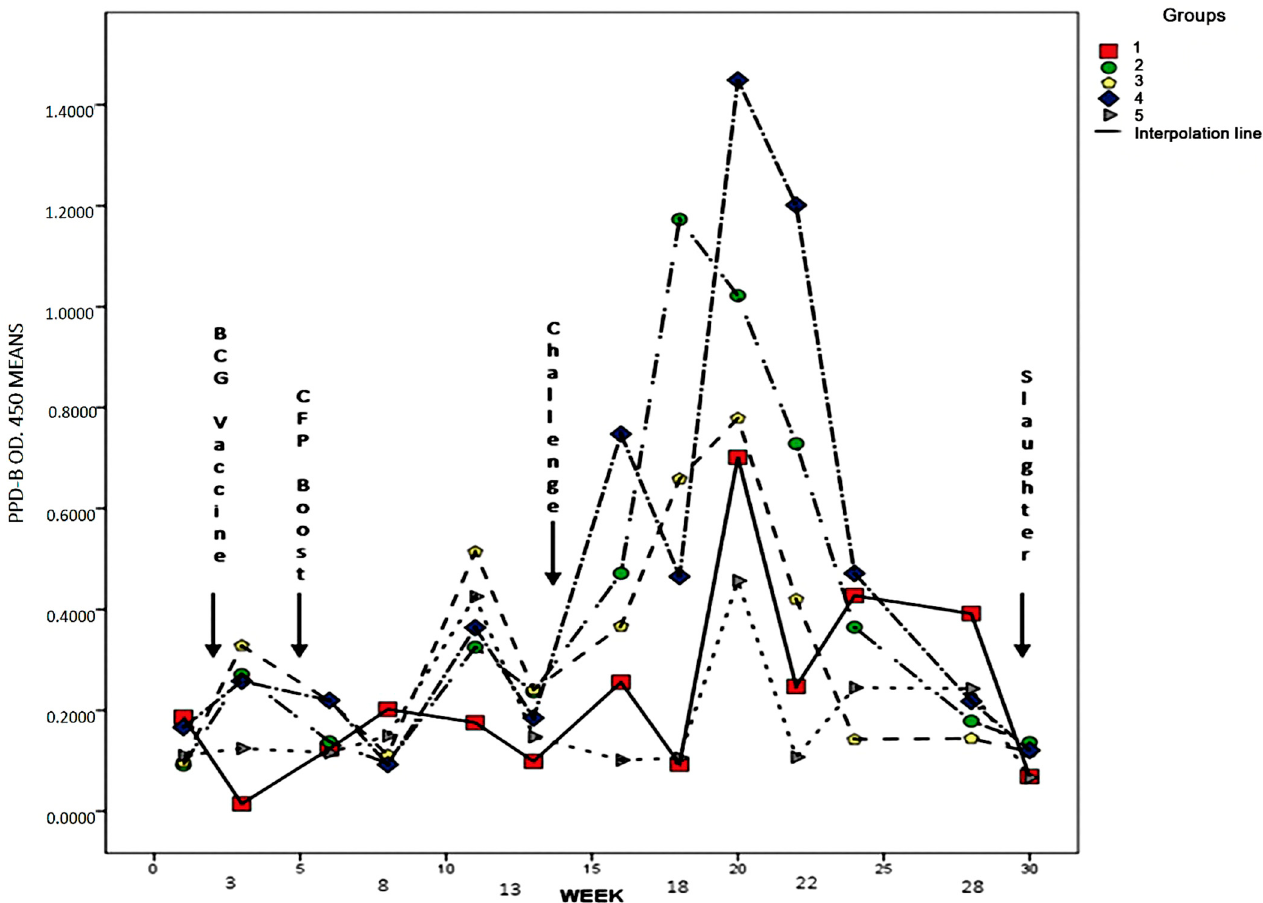
Figure 2. Antigen-specific Interferon gamma (IFN- γ ) response in goats after vaccination, boosting, and challenging with a Mycobacterium bovis wild-type strain. The purified protein derivative (PPD) bovis was used in the stimulation of whole blood in vitro. IFN- γ release values per group are expressed as the mean Optical Densities (OD 450 nm).